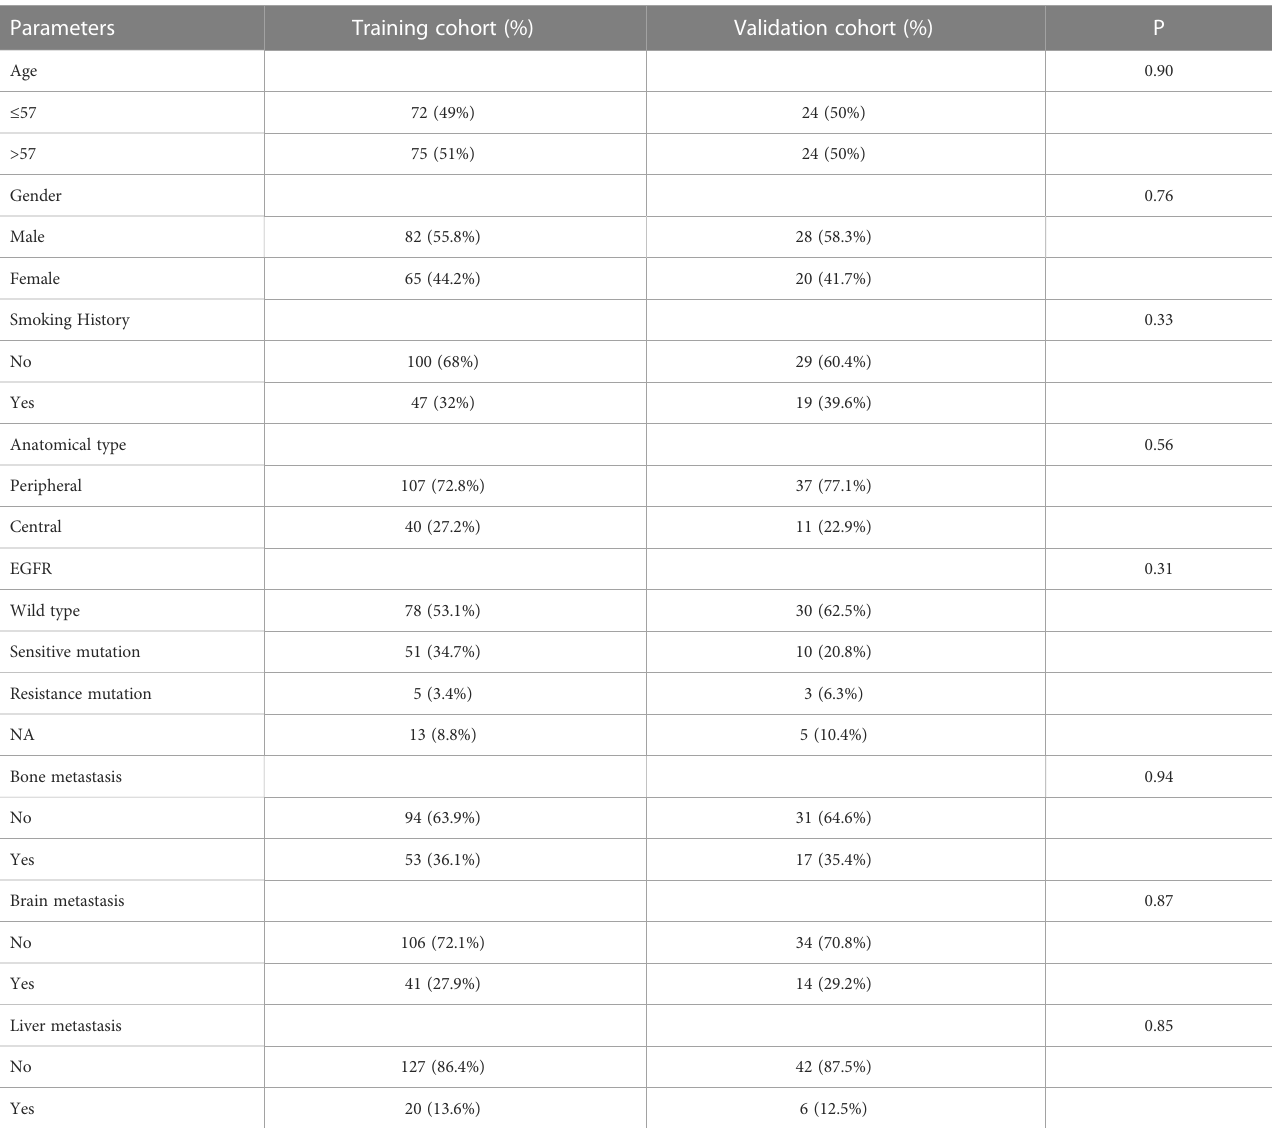
TABLE 1 Patient Demographics and Characteristics of 195